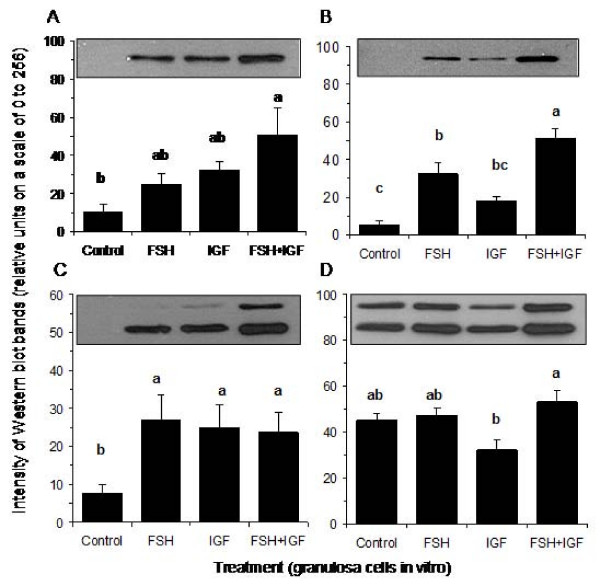
Representative Western blots and mean levels (± S.E.M) of (A) Akt, (B) p-Akt, (C) Erk and (D) p-Erk in granulosa cells (n = 4) treated with control medium, FSH (0.33 ng/ml), IGF (10 ng/ml) or FSH+IGF in combination in vitro. Bars with no common superscript are different (P < 0.05). The units represent the intensity of bands after background subtraction and are relative to white (value 0) and black (value 256). The blots each show a single band for Akt and p-Akt at about 60 kDa and each show a double band for Erk and p-Erk at about 44 and 42 kDa.